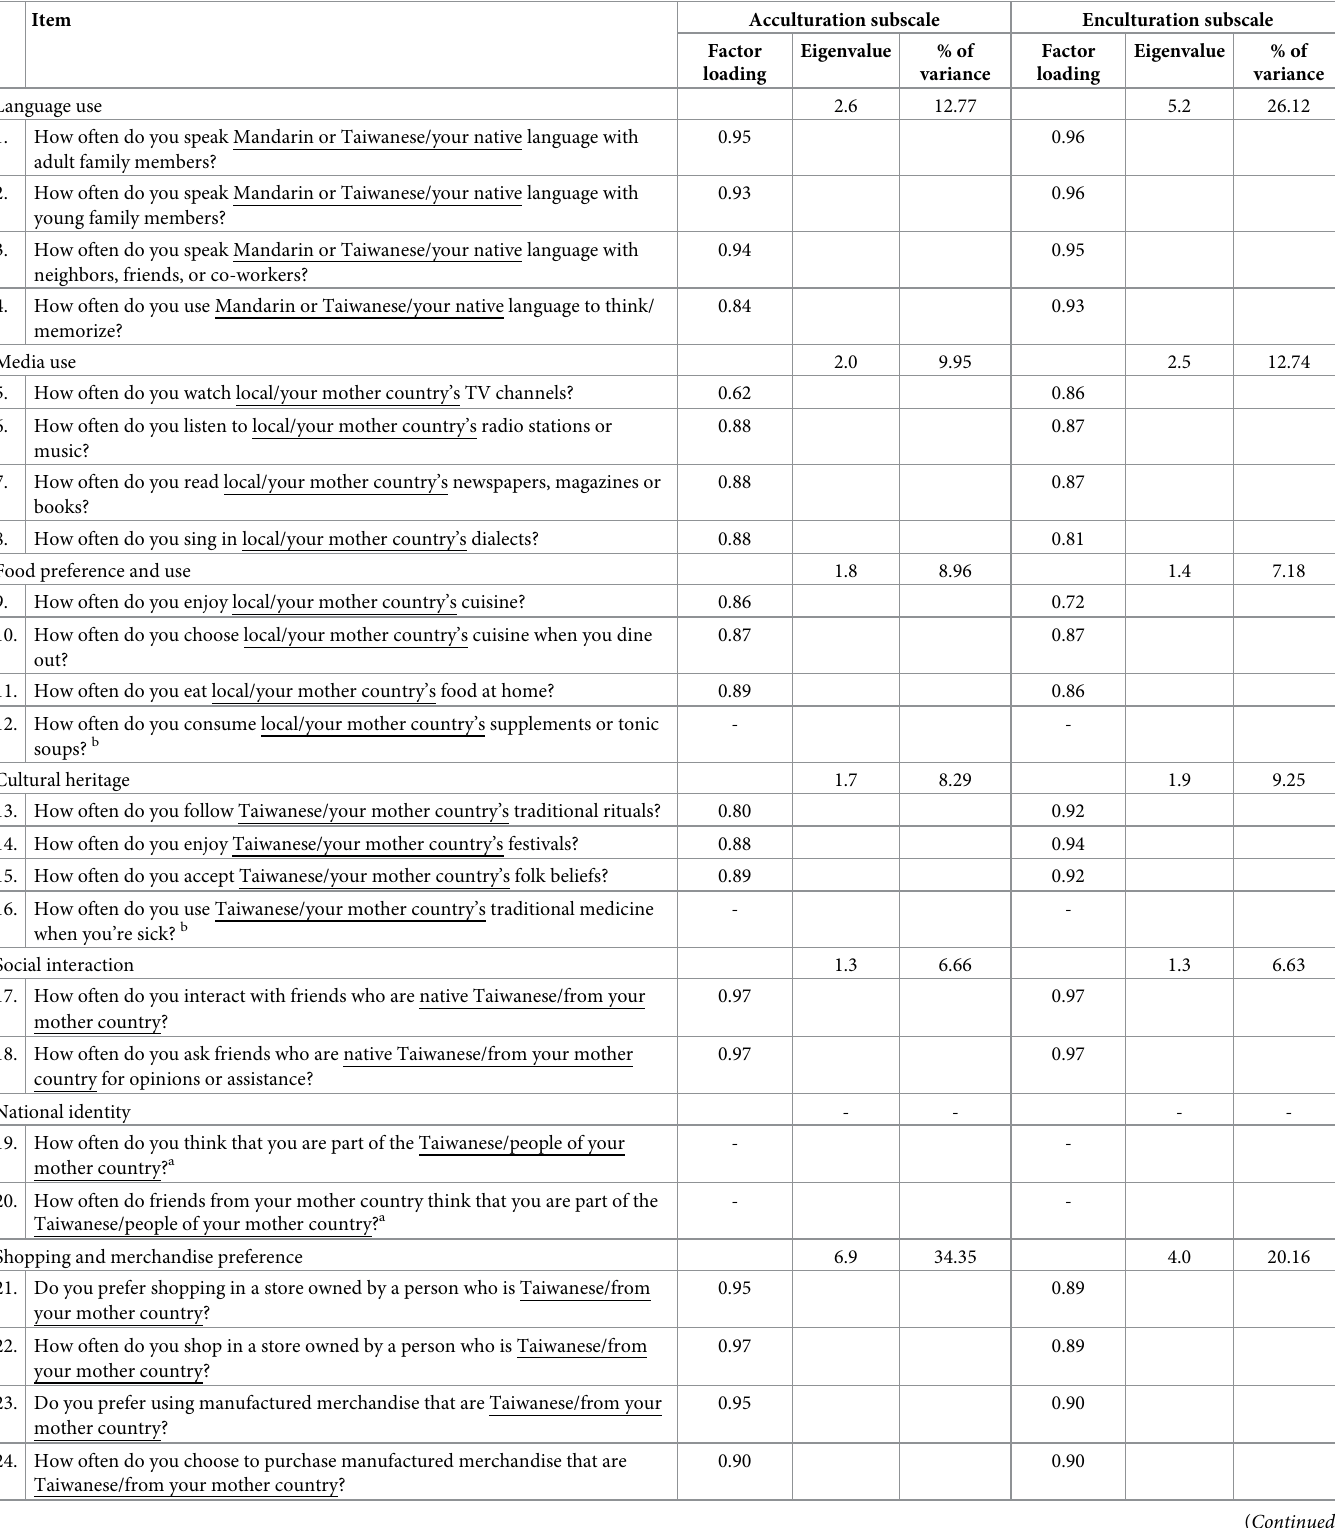
Table 1. Exploratory factor analysis of the acculturation and enculturation subscales in the Bi-dimensional Acculturation Scale for Marriage-Based Immigrant Women